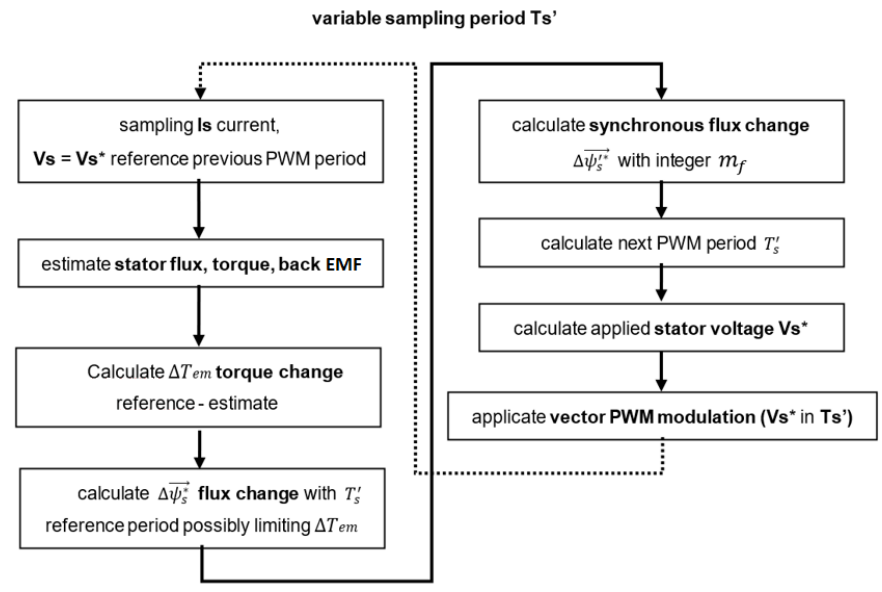
Figure 6. A flowchart of synchronous direct torque control scheme.